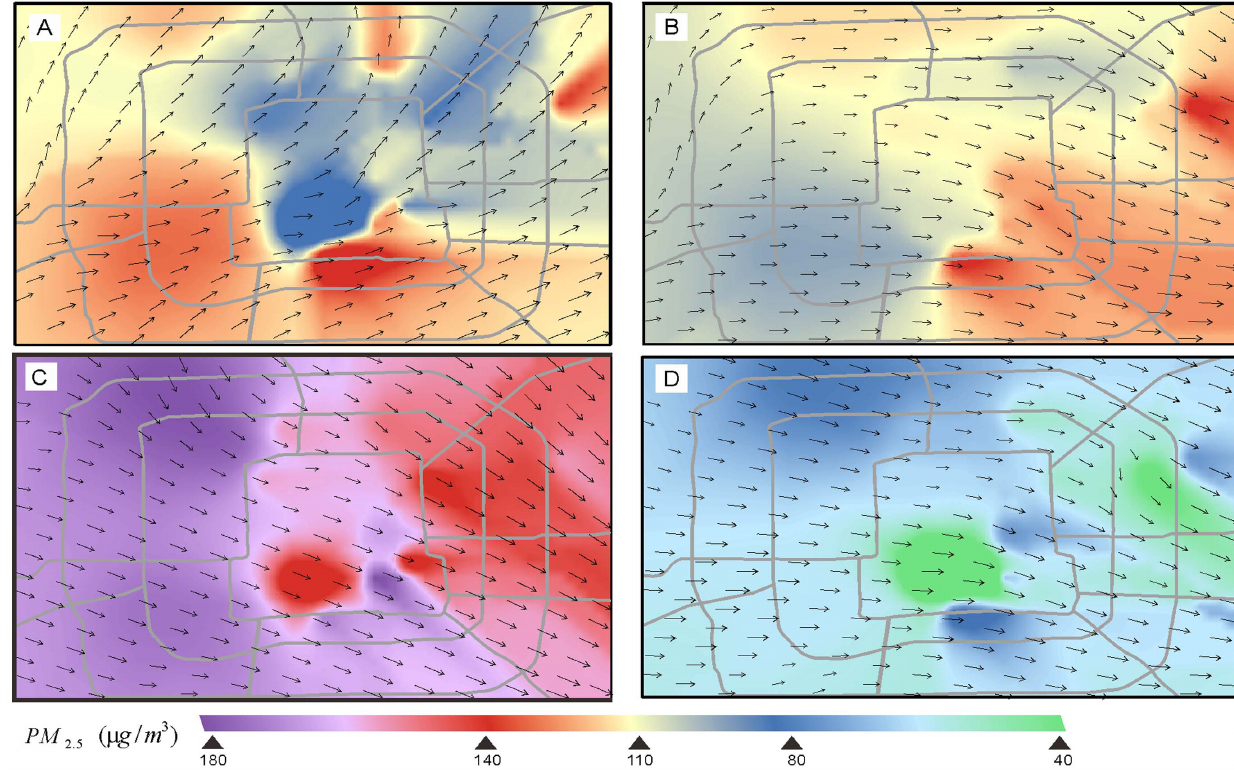
Figure 6. Interpolation results of the hourly PM 2.5 concentrations on May 26 th at various times: (A) 8 am, (B) 12 pm, (C) 4 pm and (D) 8